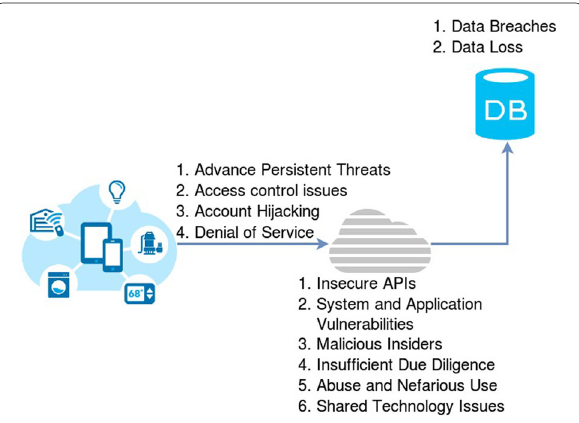
Fig. 3 Potential security issues of Fog Platform inherited from Cloud computing. This figure shows how virtualisation and other issues of Cloud platform can effect Fog platform as